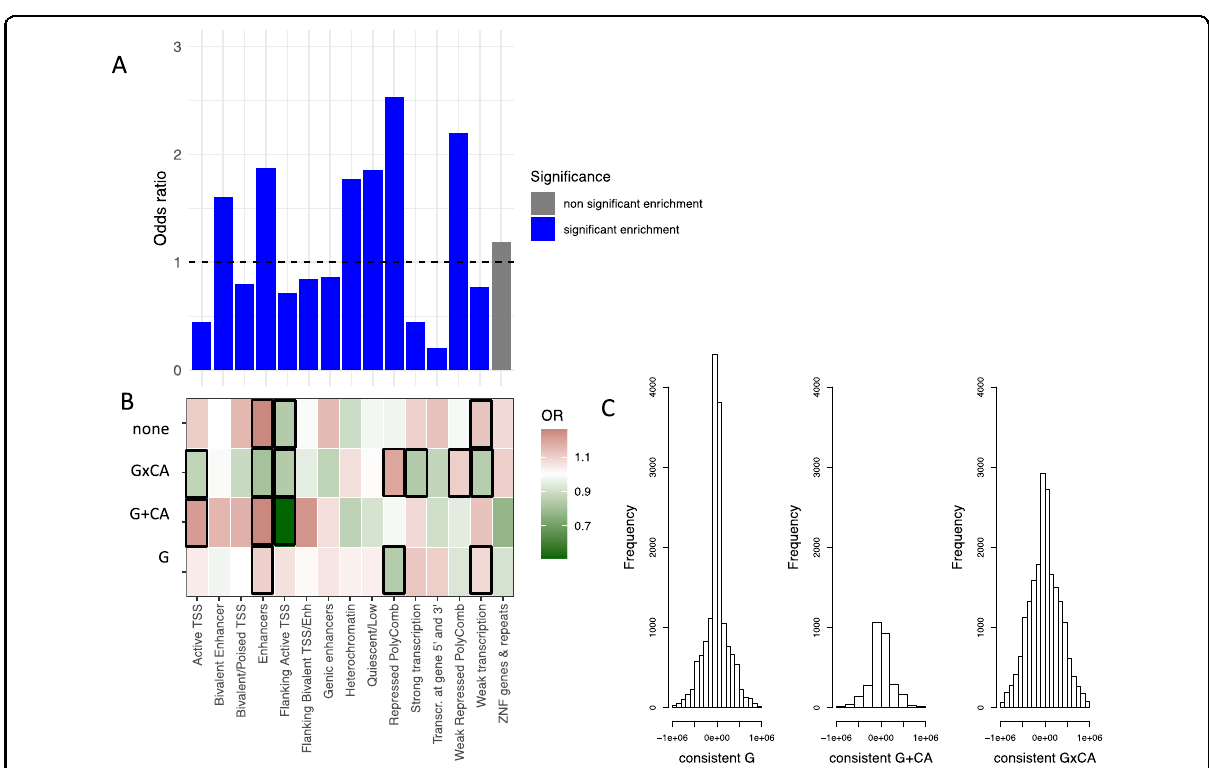
Fig. 2 Enrichment of overlapping VMPs with regard to ChromHMM states. Histone mark enrichment for overlapping VMPs with regard to other 450K CpG sites (above panel) ( a ). Histone mark enrichment for overlapping VMPs (below) with at least two consistent best G, G + CA, or G × CA models against overlapping VMPs with no consistent models. Green color indicates depletion, and red color indicates enrichment. Thick black lines around the rectangles indicate signi fi cant enrichment/depletion based on Fisher ’ s tests and a Bonferroni threshold of p < 4.66 × 10 − 04 . VMPs with at least two consistent best G × CA models were enriched in repressed Polycomb ( p = 5.48 × 10 − 19 , OR = 1.19, Fisher ’ s test) ( b ). Average distance between SNP and CpG site for consistent best G (left), consistent best G + CA (middle), and consistent G × CA models (right). CpGs with at least two consistent G × CA models presented with a signi fi cantly longer distance between SNP and VMP than VMPs with other consistent models (mean absolute distance = 271.83 kb, p < 2.20 × 10 − 16 , Wilcoxon ’ s test) ( c